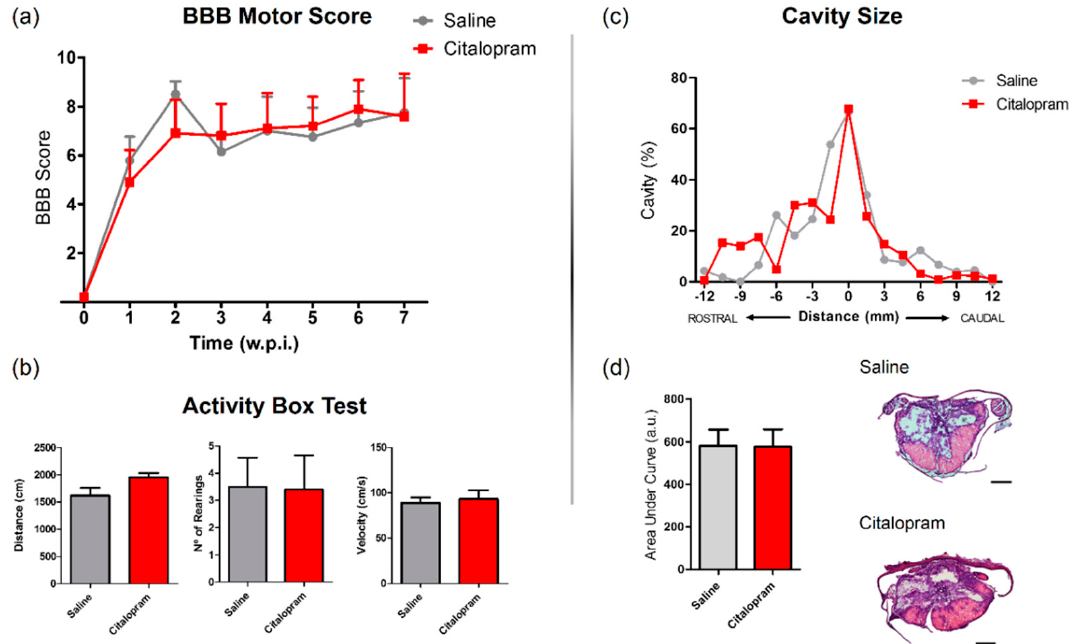
Figure 7. Impact of 7-day citalopram treatment on functional recovery and cavity analysis. ( a ) BBB score was used to assess motor recovery 3 days after the injury and once a week thereafter until the end of the experiment; ( b ) distance traveled, average velocity and the number of rearing behaviors was analyzed using the activity box test (ABT) to evaluate gross motor recovery of citalopram- vs. vehicle-treated animals; ( c ) analysis of the injury was performed by measurement of the cavity volume using hematoxylin–eosin staining; ( d ) analysis of cavity size considering the area under the curve. Citalopram- n = 7 and vehicle-treated animals n = 7. Values shown as mean ± SEM. Scale bar: 500 µ m. BBB—Basso, Beattie and Bresnahan.